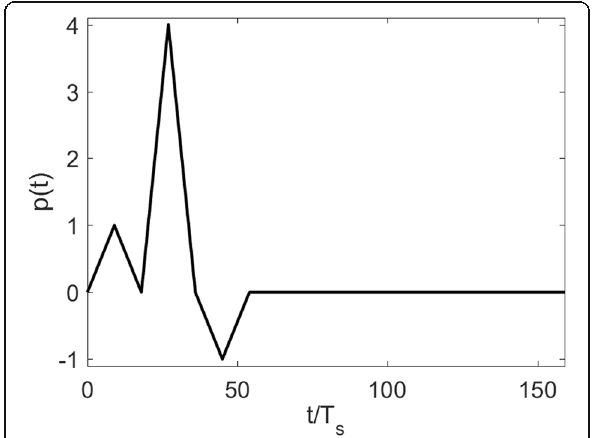
Fig. 1 Pulse p ( t ) for the signal specified by Eq.